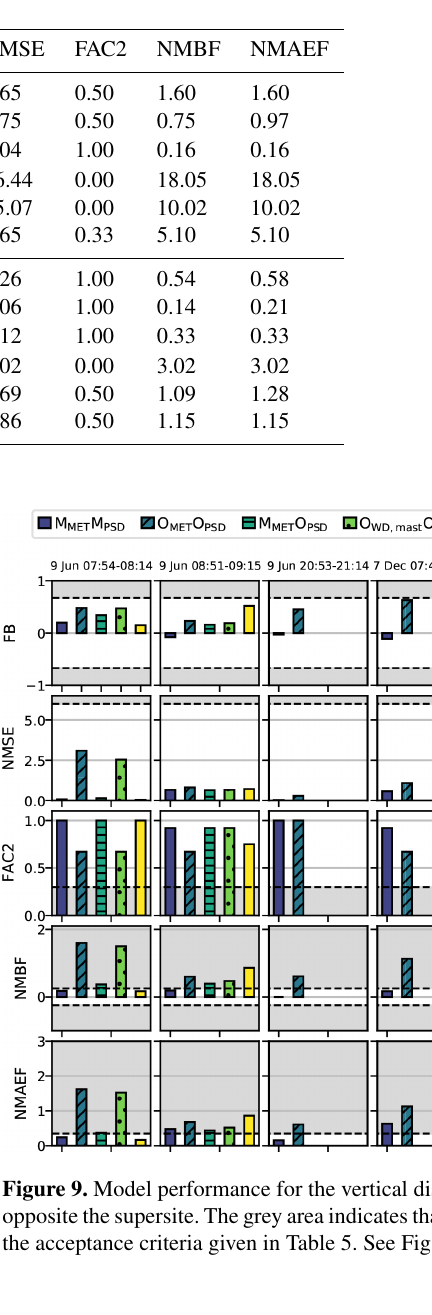
Table 6. Performance of the modelled aerosol chemical composition at the supersite on the morning of 9 June between 07:16 and 09:15LT. See Fig. 4 for further description.